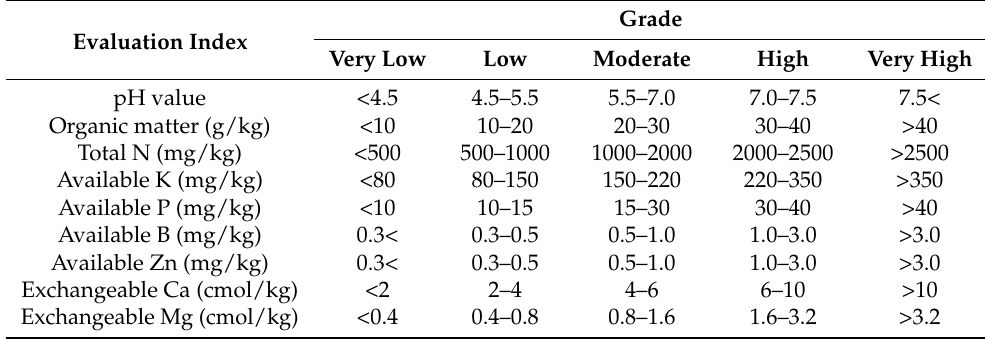
Table 2. Evaluation criteria of abundance and deficiency for nutrients in tobacco planting